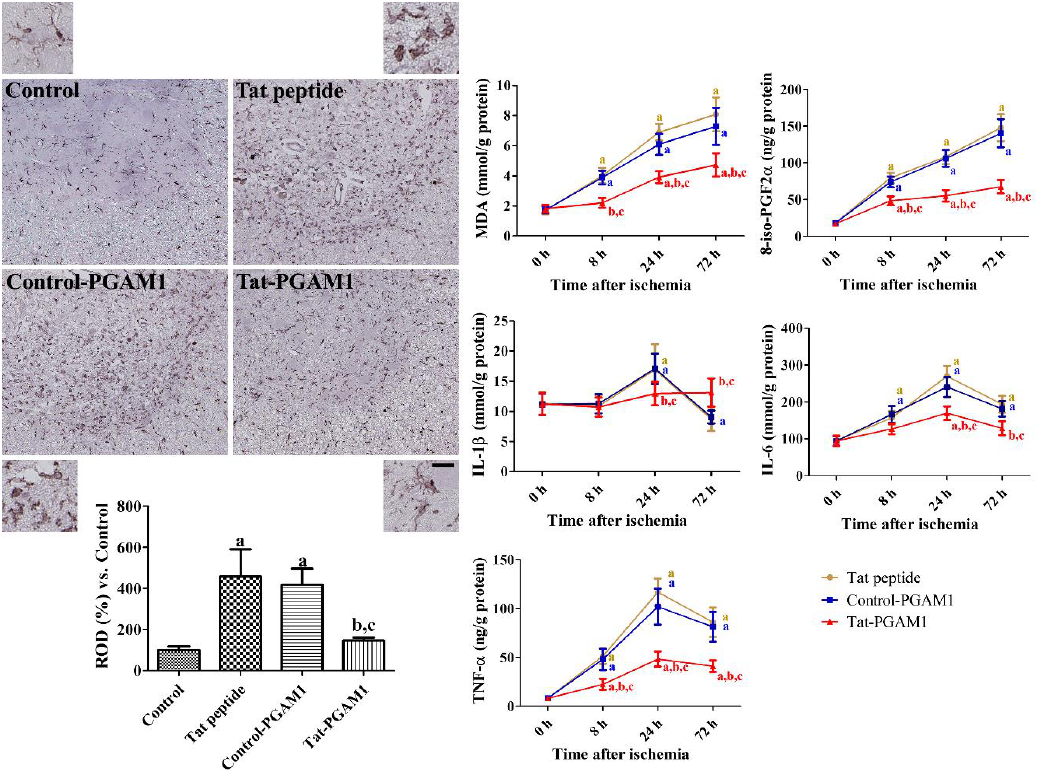
Figure 4. The anti-oxidative and anti-inflammatory effects of Tat-PGAM1 and Control-PGAM1 against ischemic damage in the rabbit spinal cord. Iba-1 immunohistochemistry was conducted to visualize the morphology of microglia/macrophages in the ventral horn of the spinal cord. Scale bar = 100 μm, 25 μm (inset image). The relative optical densities were expressed as percentile values of Iba-1immunoreactivity versus control group per section. The lipid peroxidation and oxidized arachidonic acid were determined by MDA and 8-iso-PGF2 α assay, respectively, after ischemia / reperfusion. In addition, pro-inflammatory cytokines, such as Interleukin (IL)-1 β , IL-6, and tumor necrosis factor (TNF)- α were measured in the spinal cord after ischemia / reperfusion. The data were analyzed using one- or two-way ANOVA followed by Bonferroni’s post hoc test ( a p < 0.05, significantly di ff erent from the control group; b p < 0.05, significantly di ff erent from the Tat peptide group; and c p < 0.05, significantly di ff erent from the Control-PGAM1 group). The bar graph represents the mean ± standard deviation